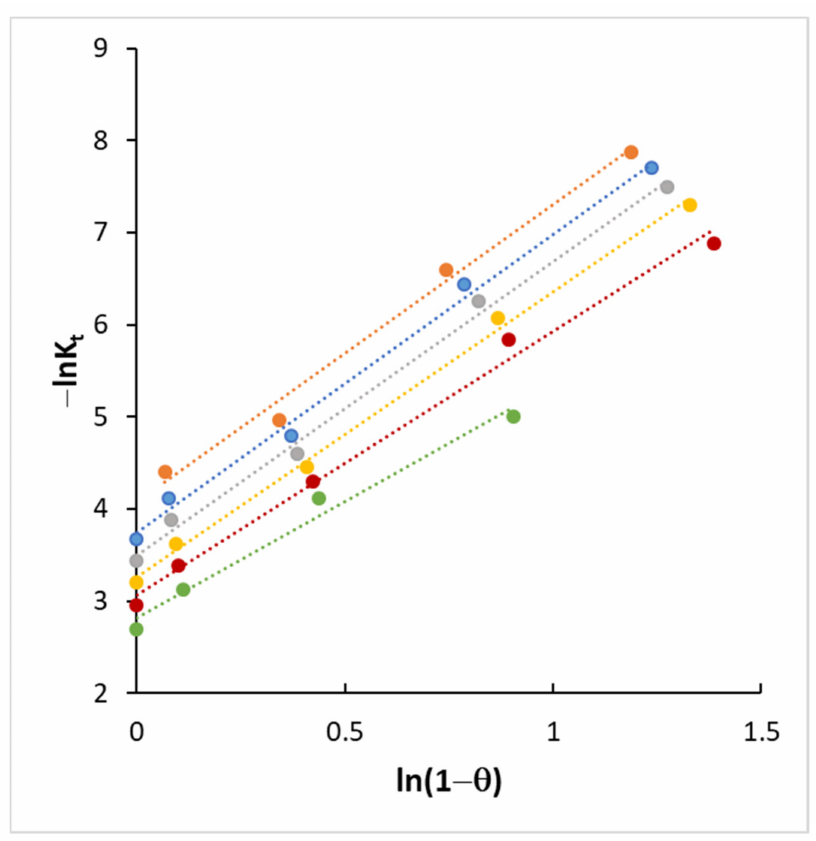
Figure 7. Plot of − lnK t vs. ln(1 − θ ), for different values of E − Φ 2 (mV): − 500 (orange), − 520 (blue), − 540 (grey), − 560 (yellow), − 580 (red), − 600 (green).